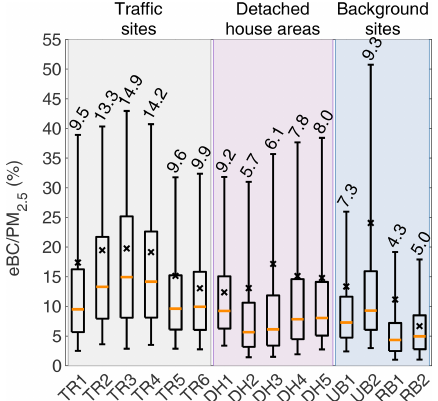
Figure 3. Statistics of eBC / PM 2 . 5 fraction at each station. The ex- planation for the markers is the same as in Fig. 2, except here the values reported above each box are the median